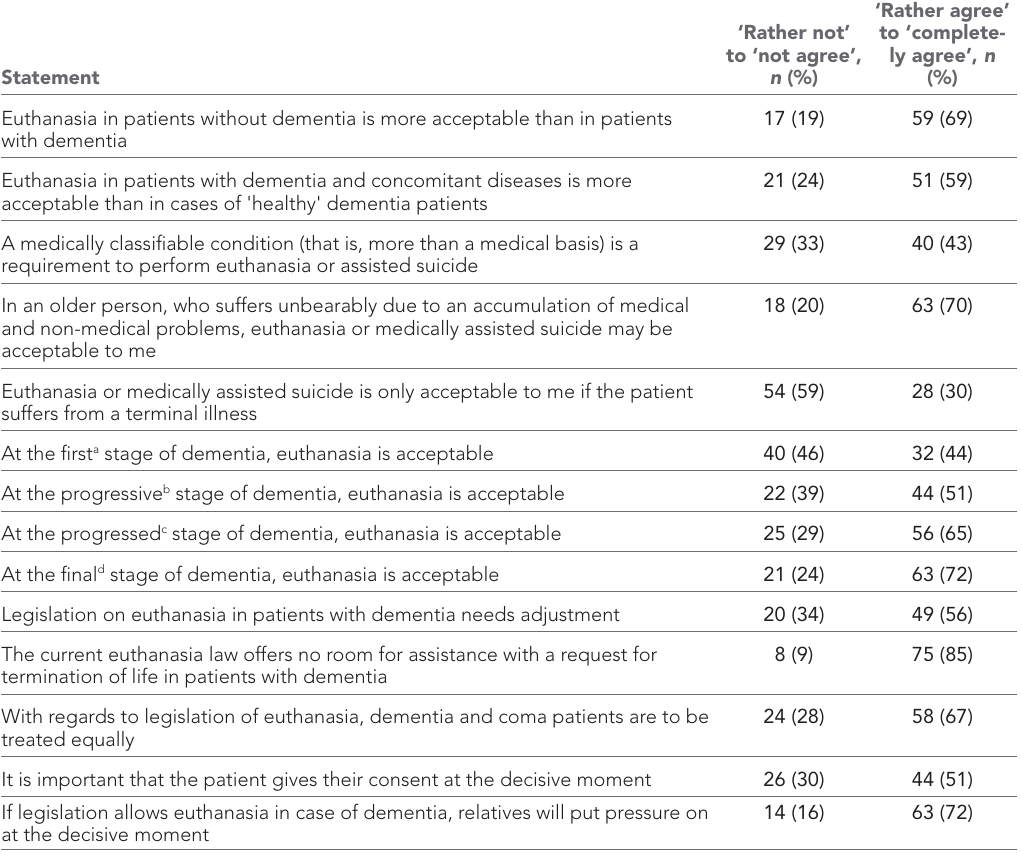
Table 2 Participant responses to statements regarding dementia and euthanasia (5- point Likert